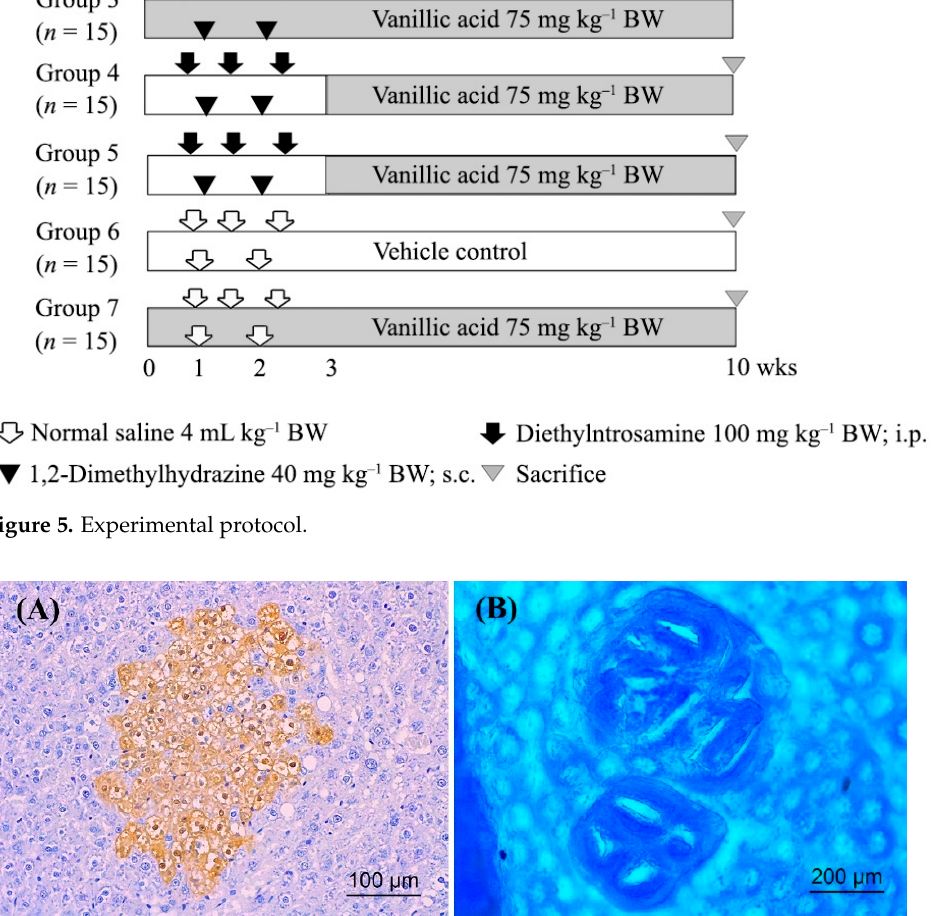
Figure 5. Experimental protocol.